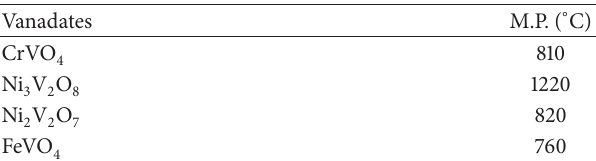
Table 2: Melting points of the metallic vanadates formed during the corrosion process of Cr, Ni, and